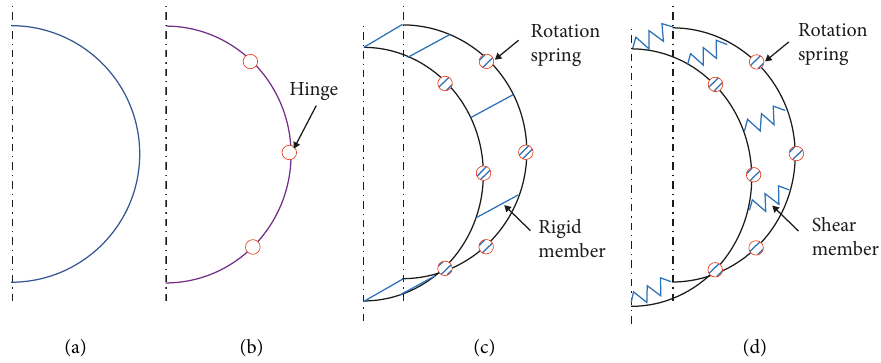
Figure 1: Types of segmented joints (Koyama [18]). (a) Uniform rigid ring. (b) Multihinge ring. (c) Beam spring (I). (d) Beam spring